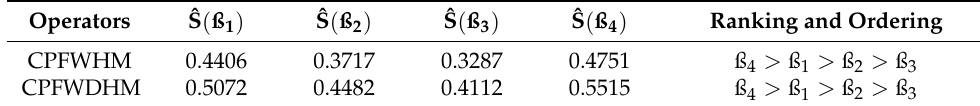
Table 4. Score values of different software applications for a VMS. Operators